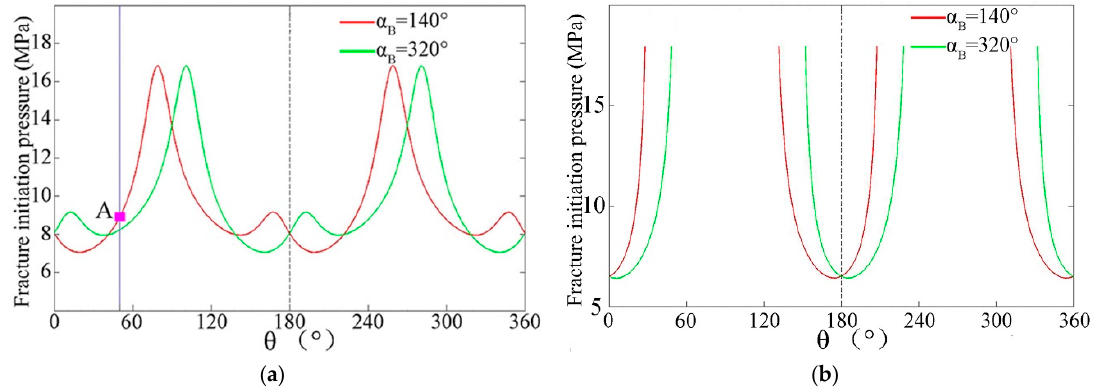
Figure 7. Fracture initiation pressure of the bedding planes with 𝛼 (cid:3009) = 20°, 𝛼 (cid:3003) = 140° or 320°, 𝛽 (cid:3003) = 10° for ( a ) shear slippage along the bedding planes and ( b ) tensile failure of the bedding